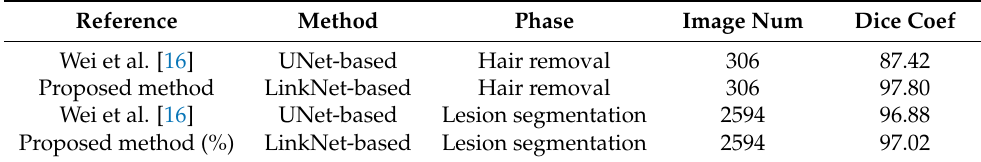
Table 5. Comparison of two methods in the hair removal phase with the ISIC 2018